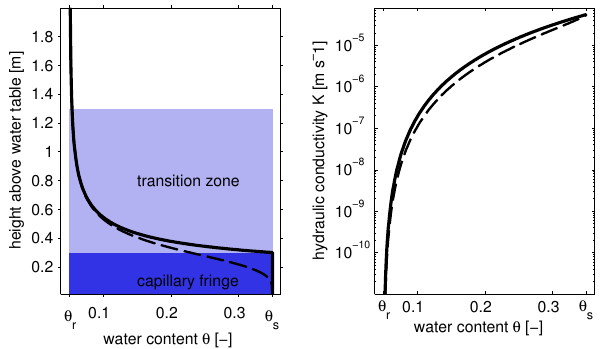
Figure 4. The sketch on the left shows the capillary fringe and the transition zone from saturated water content θ s to residual water content θ r above a water table for a generic coarse sand in equi- librium. The thick black line represents a Brooks–Corey parame- terization of the soil water characteristic; the dashed black line de- notes the soil water characteristic using the corresponding simpli- fied Mualem–van Genuchten parameterization for the same sand. The diagram on the right shows the corresponding hydraulic con- ductivity functions as a function of water content. Note the logarith- mic scale of the ordinate. For a detailed overview of the parameters, refer to Table